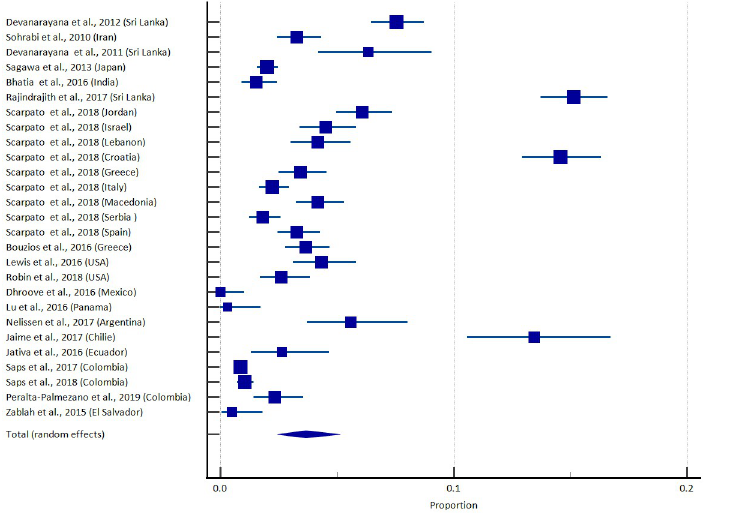
Fig 2. Forest plot prevalence of